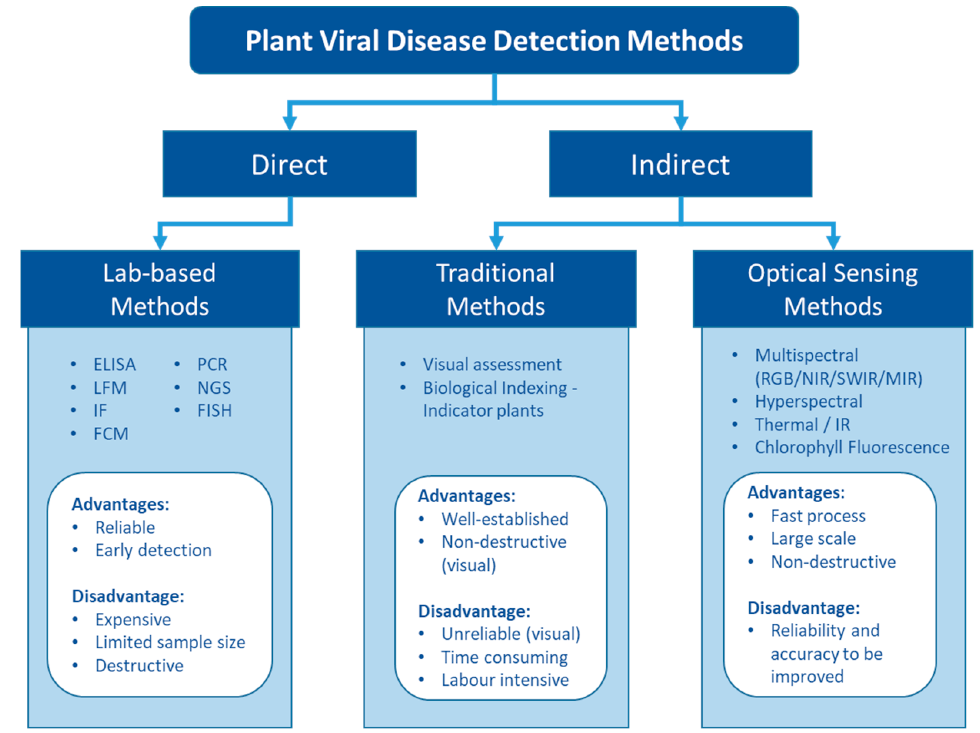
Figure 1. The pros and cons of different types of detection methods for plant